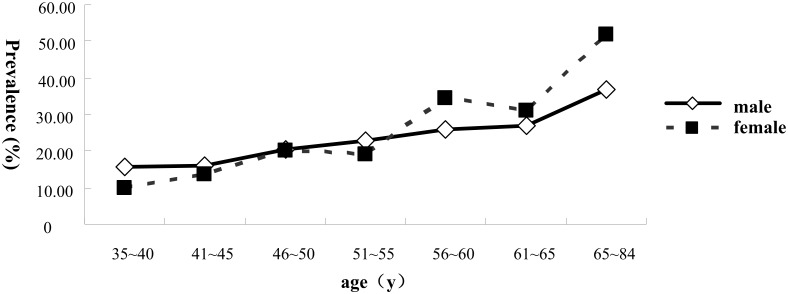
Age-specific prevalence of hypertension in both sexes.